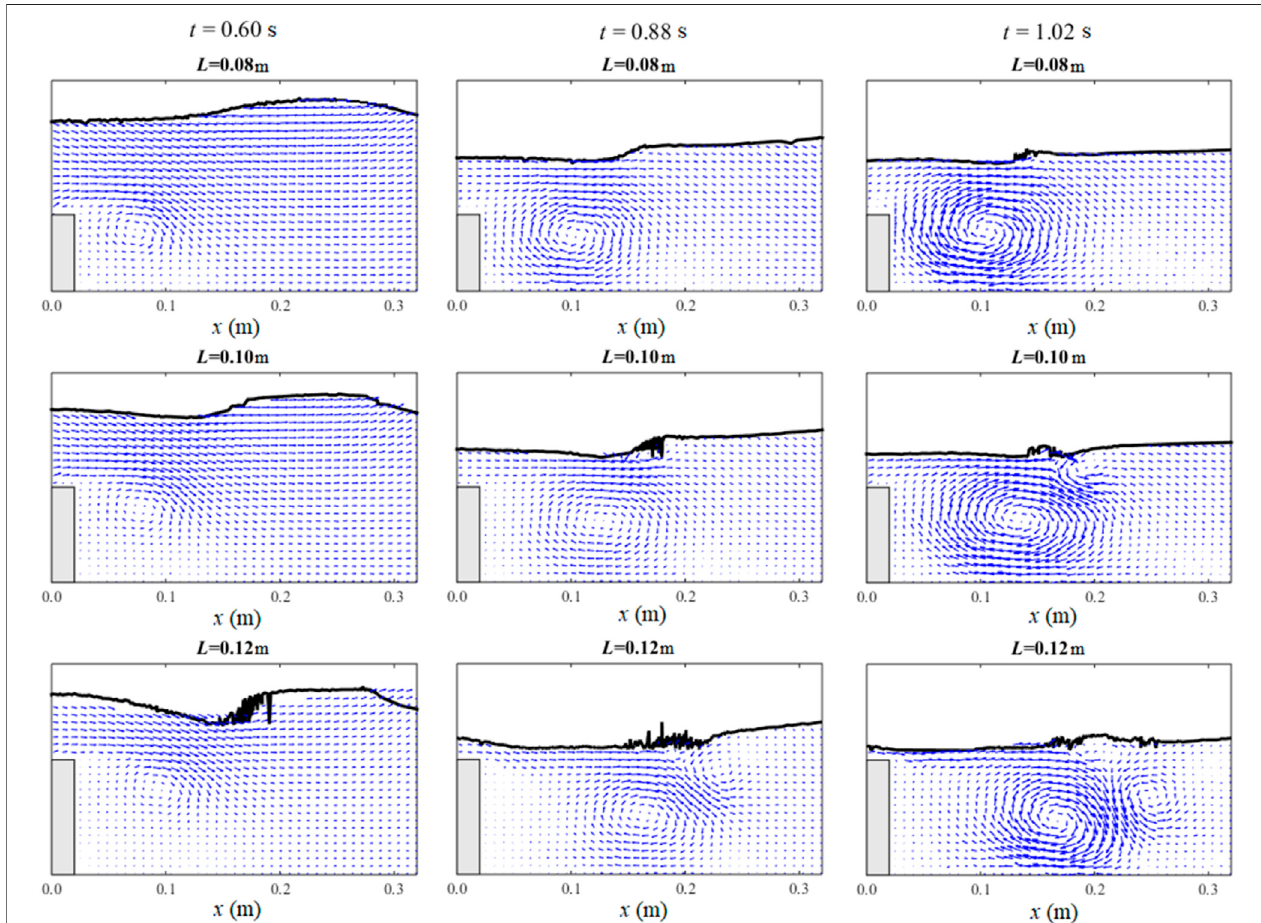
FIGURE 10 | Comparisons of calculated velocity vector fi elds for different vertical lengths of the barrier.